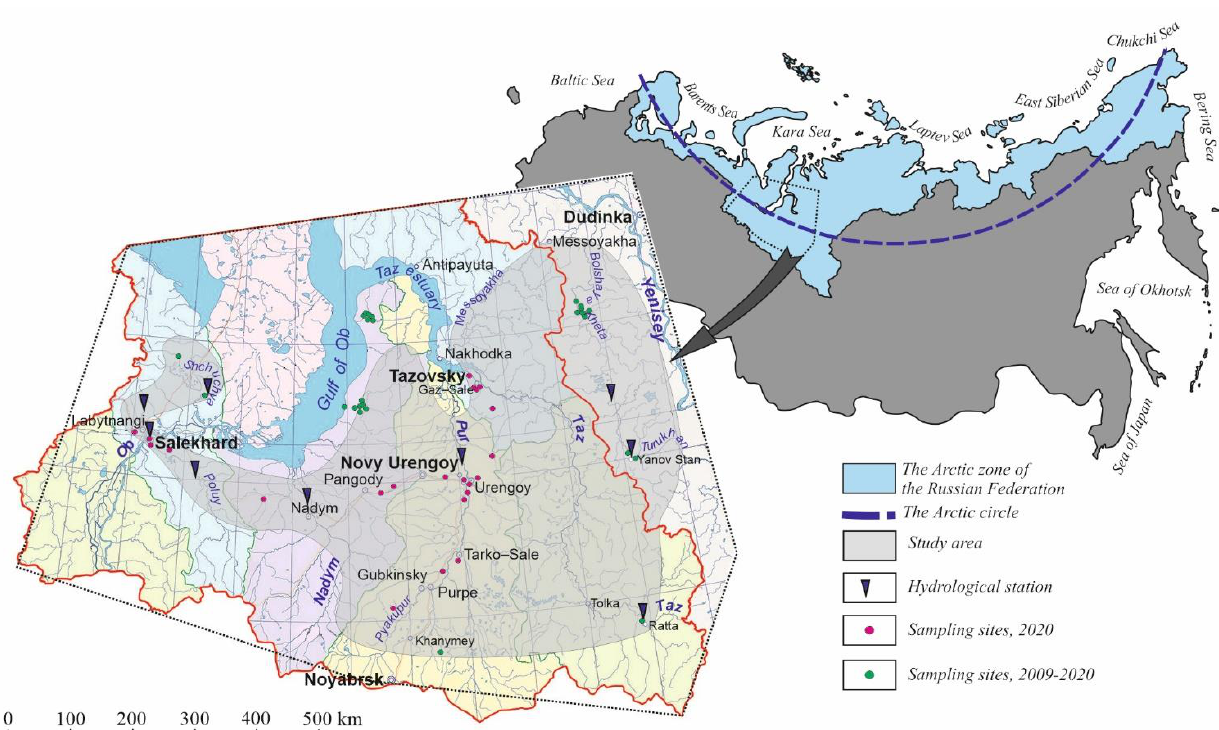
Figure 1. Location map of study area in northern West Siberia.